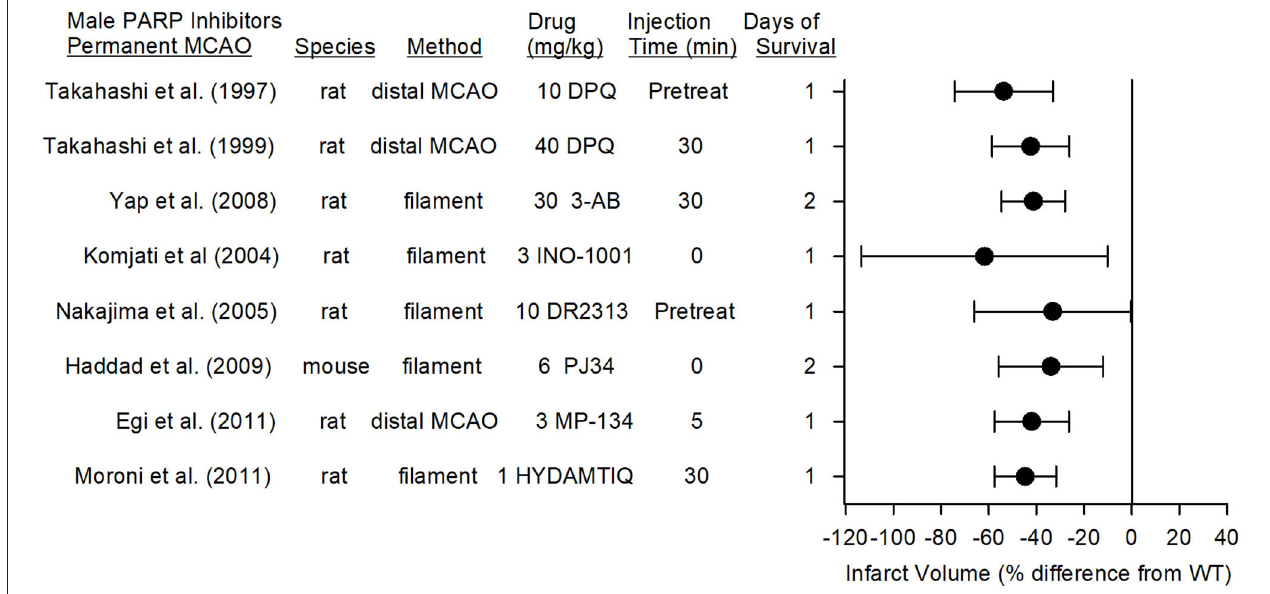
FIGURE 5 | Effect sizes and 95% confidence intervals of PARP inhibitor treatment on infarct volume after permanent middle cerebral artery occlusion (MCAO) in male mice and male rats, relative to their respective controls, were derived from mean and SD values and sample sizes extracted from publications by Takahashi et al. (96), Takahashi et al. ( 97), Yap et al. (98), Komjati et al. (85), Nakajima et al. (87), Haddad et al. (99), Egi et al. (88), and Moroni et al. (89). These reports from six laboratories using 7 distinct inhibitors showed a significant reduction in infarct